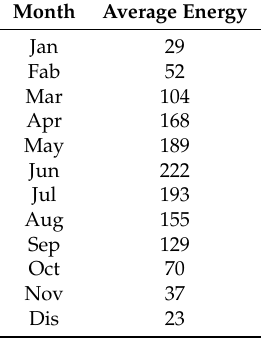
Table 4. Average energy production (Wh/day) from a PV solar panel based on solar irradiation at the Wave Hub.